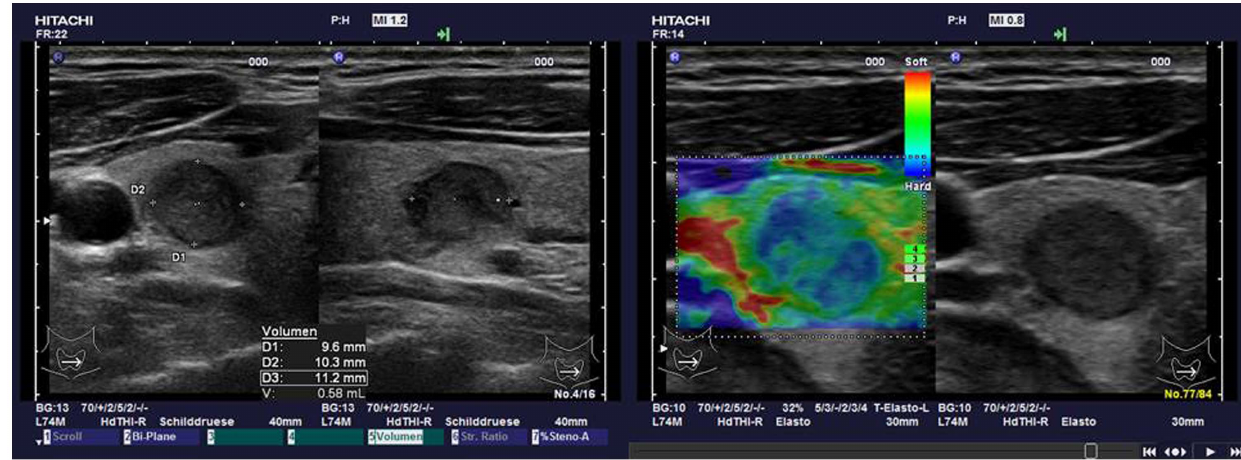
Figure 2. Example of TIRADS and SE of papillary carcinoma: 10 mm nodule in the right thyroid gland classified as TIRADS 4 (consistent with malignancy) in the left image and SE 3 (predominantly blue = hard; consistent with malignancy) in the right image. Histology revealed a papillary T2 carcinoma.